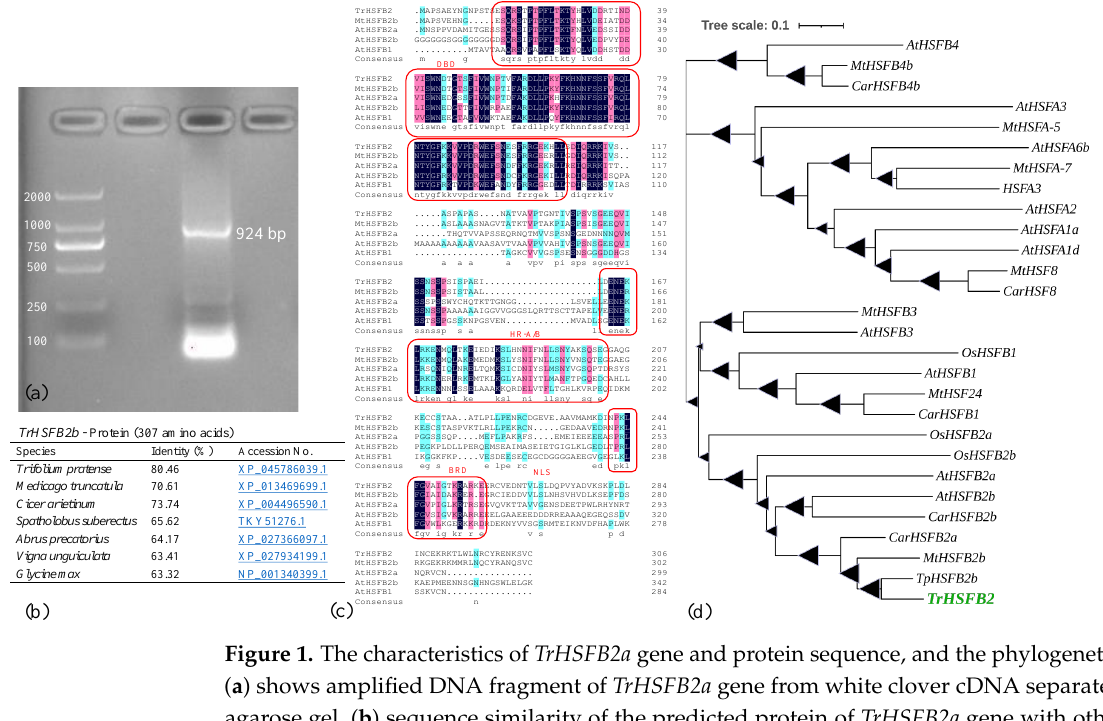
Figure 1. The characteristics of TrHSFB2a gene and protein sequence, and the phylogenetic analysis. ( a ) shows amplified DNA fragment of TrHSFB2a gene from white clover cDNA separated on 1.5% agarose gel, ( b ) sequence similarity of the predicted protein of TrHSFB2a gene with other species, ( c ) comparison of amino acids sequences of TrHAFB2a with related HSF proteins—highly homolog amino acids residue are shaded and conserved domains are boxed. ( d ) Phylogenetic relationship of the protein of TrHSFB2a gene with other plant species and other members of HSF family of the Arabidopsis thaliana . Triangles size in branches represents bootstrap values. Phylogenetic tree analysis was based on minimum evolution using Mega (version